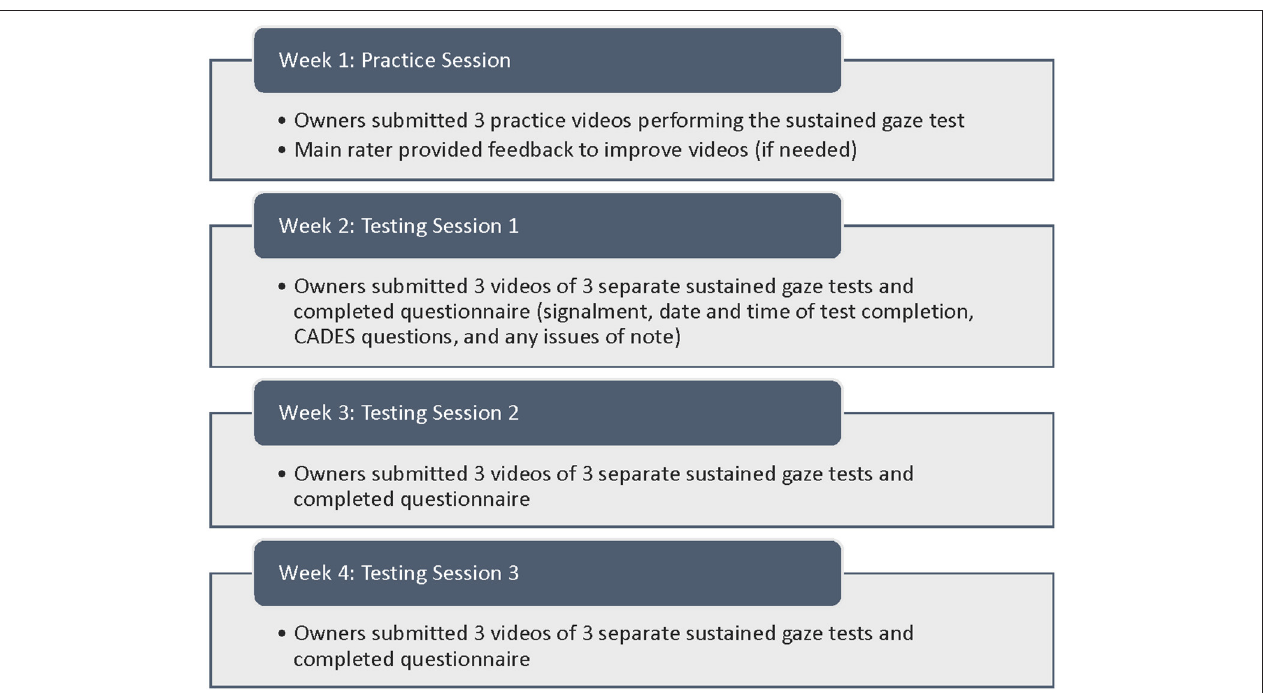
FIGURE 1 | Chart depicting the testing performed each week of the study.